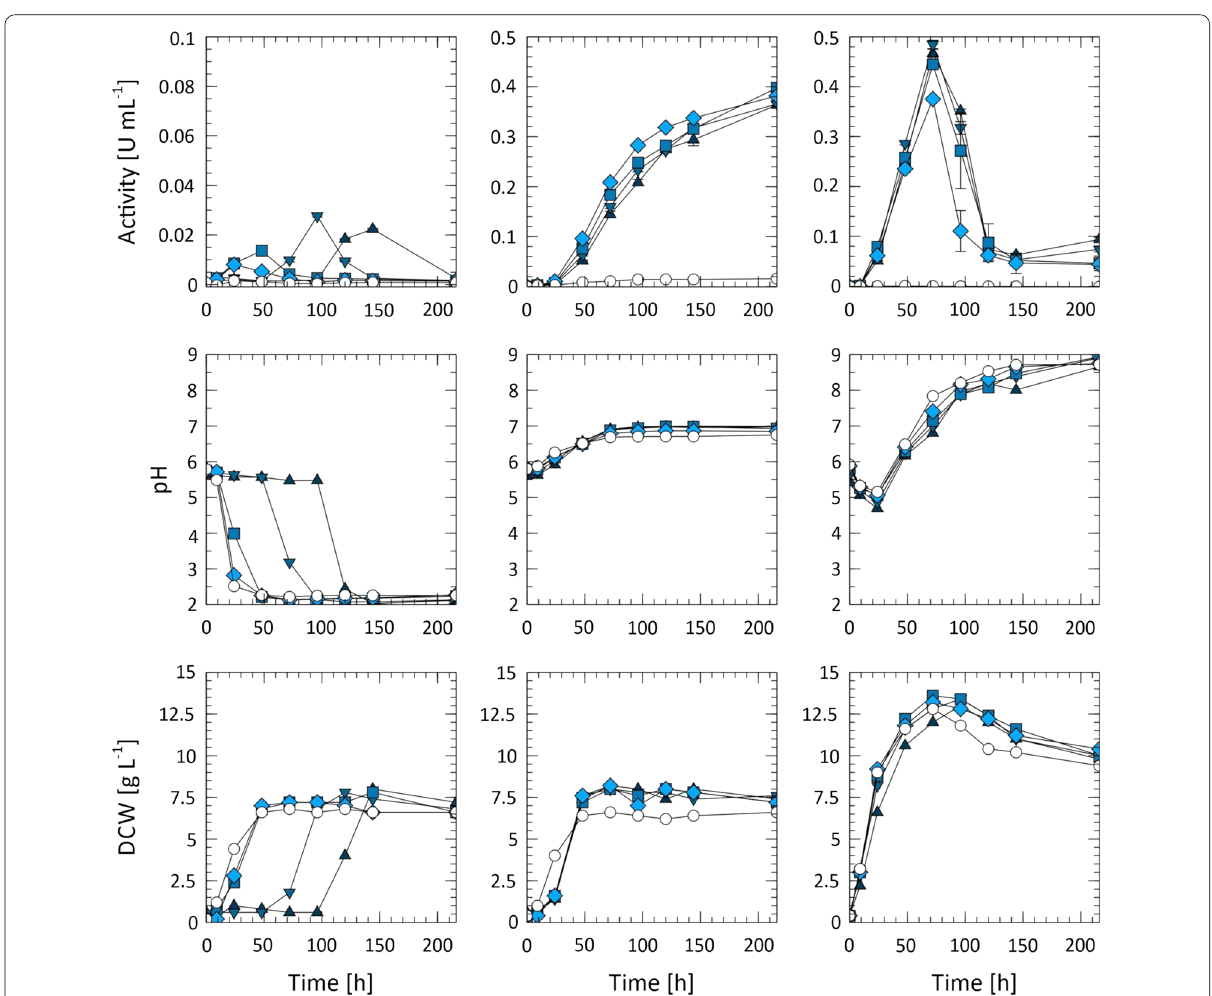
Fig. 2 Analysis of Tvlcc5 synthesis by A. adeninivorans G1212/YRC102-TEF1-TVLCC5-6H in YMM-NH 4 (left), YMM-NO 3 (middle), and YPD (right) containing 0 mM (white circle), 0.2 mM (diamond), 0.5 mM (square), 1.0 mM (triangle down), and 2.0 mM (triangle up) CuSO 4